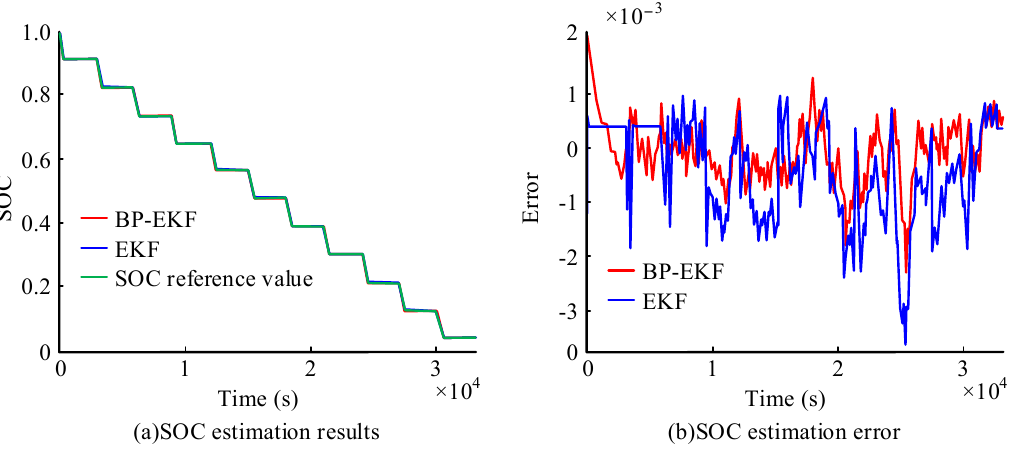
Figure 6. SOC estimation results and errors of the model under pulse discharge conditions. As can be seen in Figure 6, the difference between the appraised and true values of the EV E-cell SOC using the model under pulse discharge conditions is small, and the model is able to converge to the true value quickly, with a maximum error of 1.0367% and an average error of 0.0231% in the model SOC estimation. The results and errors of the model E-cell SOC estimation under UDDS conditions are shown in Figure 7.